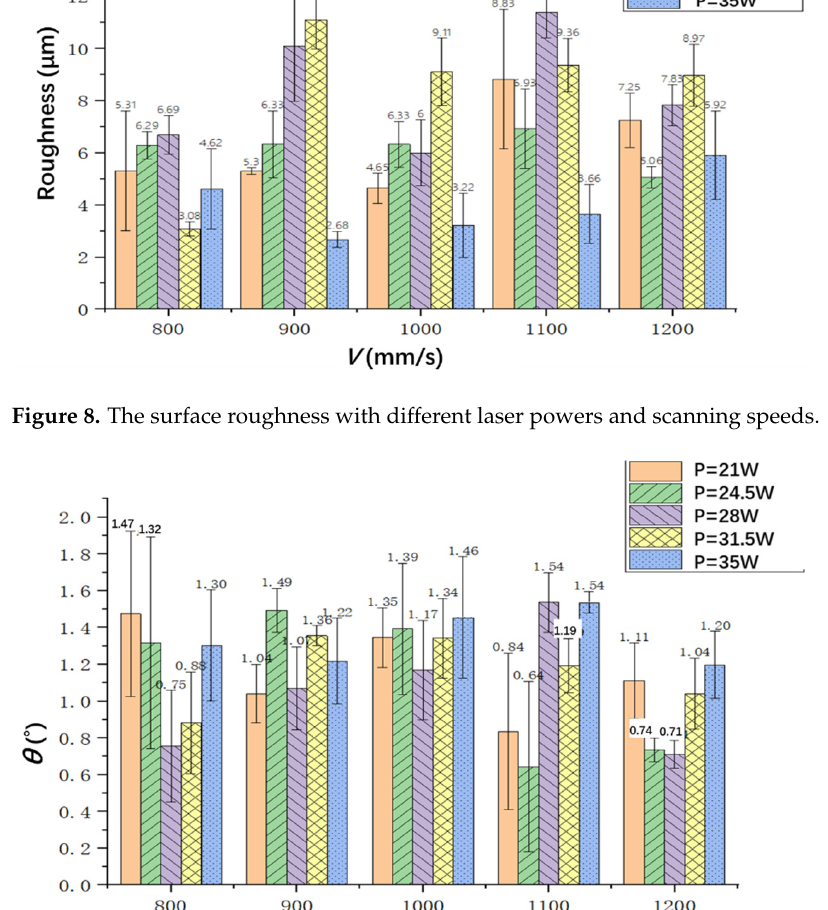
Figure 8. The surface roughness with different laser powers and scanning speeds.